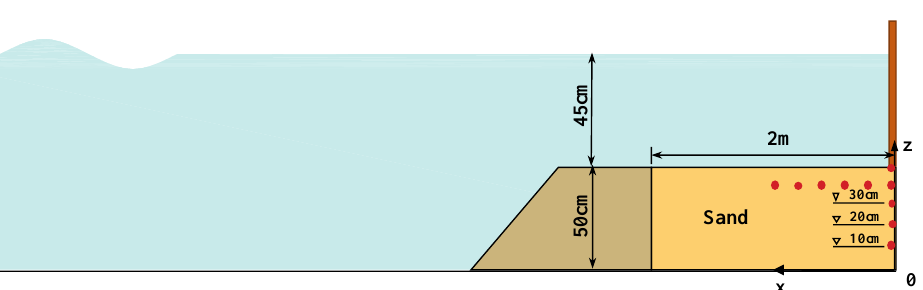
Figure 3. Tsai and Lee (1995)’s experiment for the standing wave-induced seabed response.